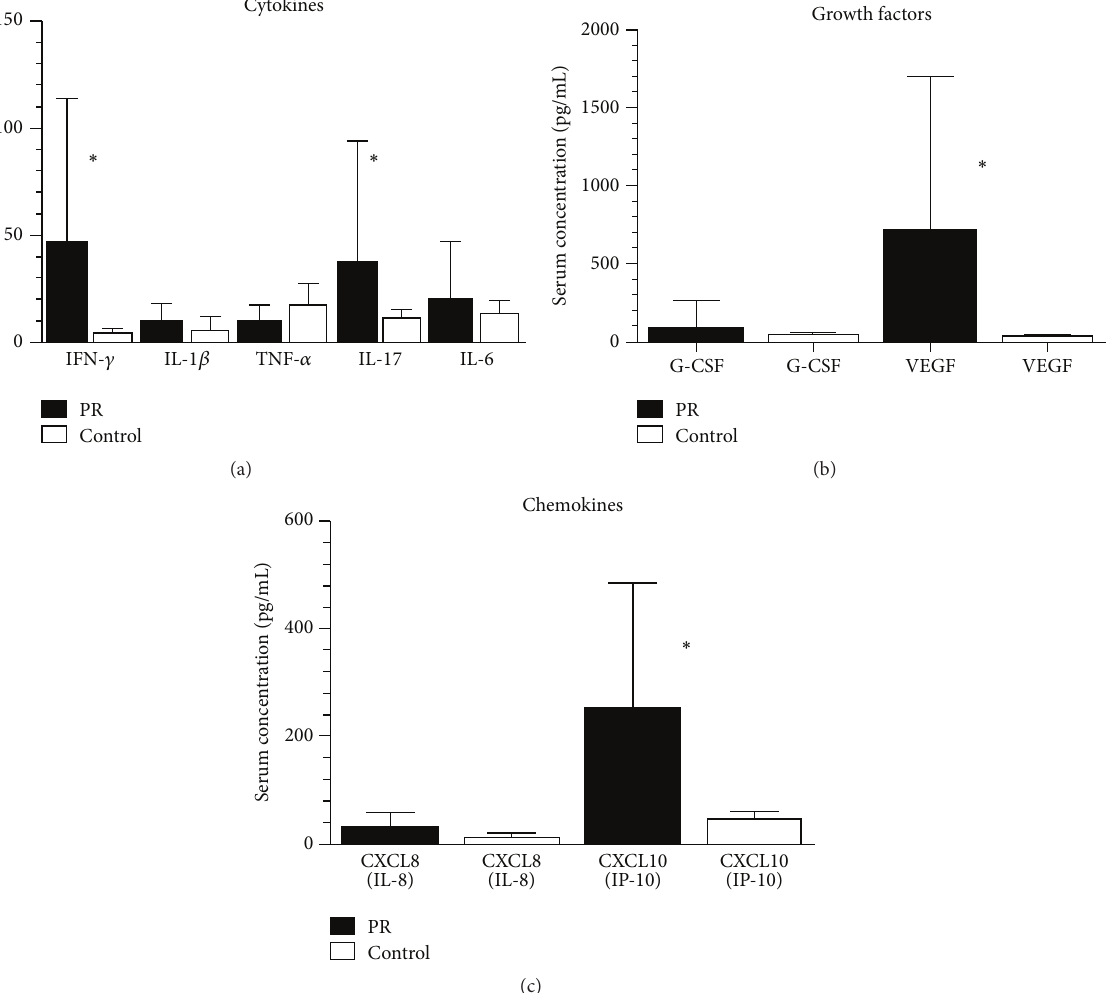
Figure 1: Comparison of various serum cytokine levels (circulating cellular cytokines, growth factors, and chemokines) between PR patients ( 𝑛 = 24 ) and controls ( 𝑛 = 24 ). Bars show the mean in pg/mL and SEM. ∗ Significantly different from compared values by Mann-Whitney 𝑈 test ( 𝑃 < 0.005